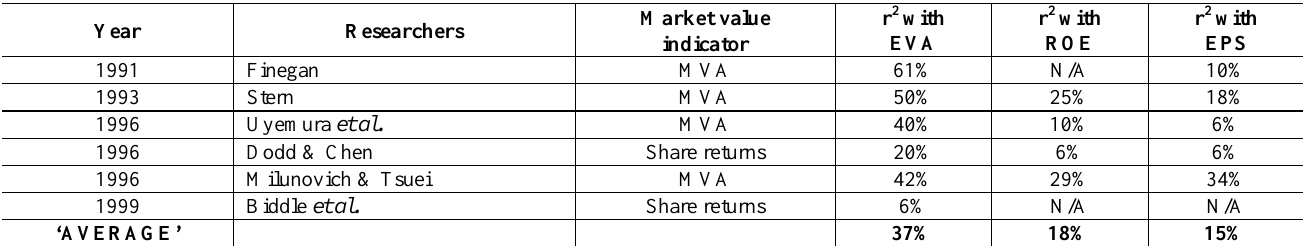
Table 2: Regression of market value and EVA, ROE and